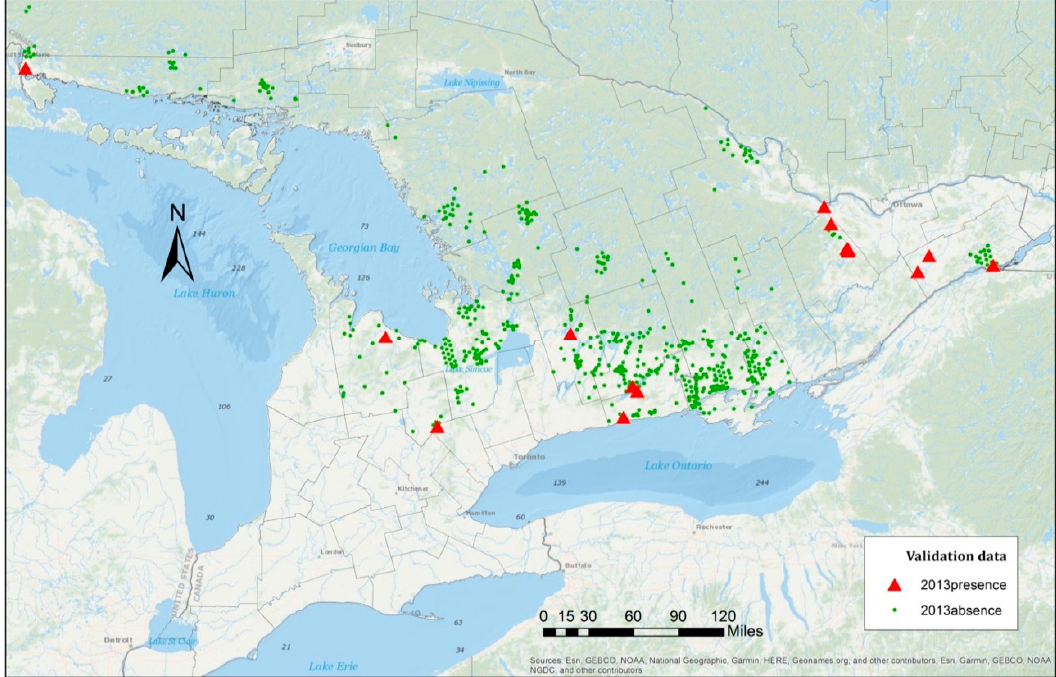
Figure 5. Sampled points in Southern Ontario in 2013. Green points are the EAB absence points and red points are the EAB presence points. Please note that due to the close proximity of many points, it seems that there are fewer presence points visible than there actually are. Table 7. Classification accuracy for the validation and testing datasets by the GLM (Generalized